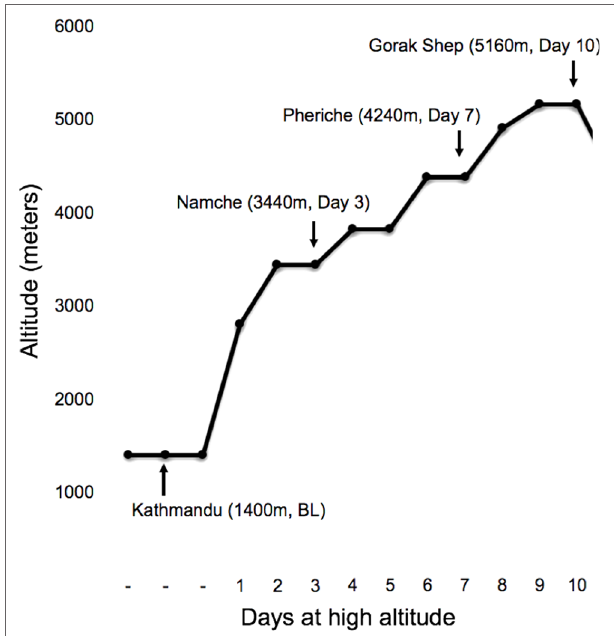
fIGURe 1 | Trekking profile with the sampling locations marked by